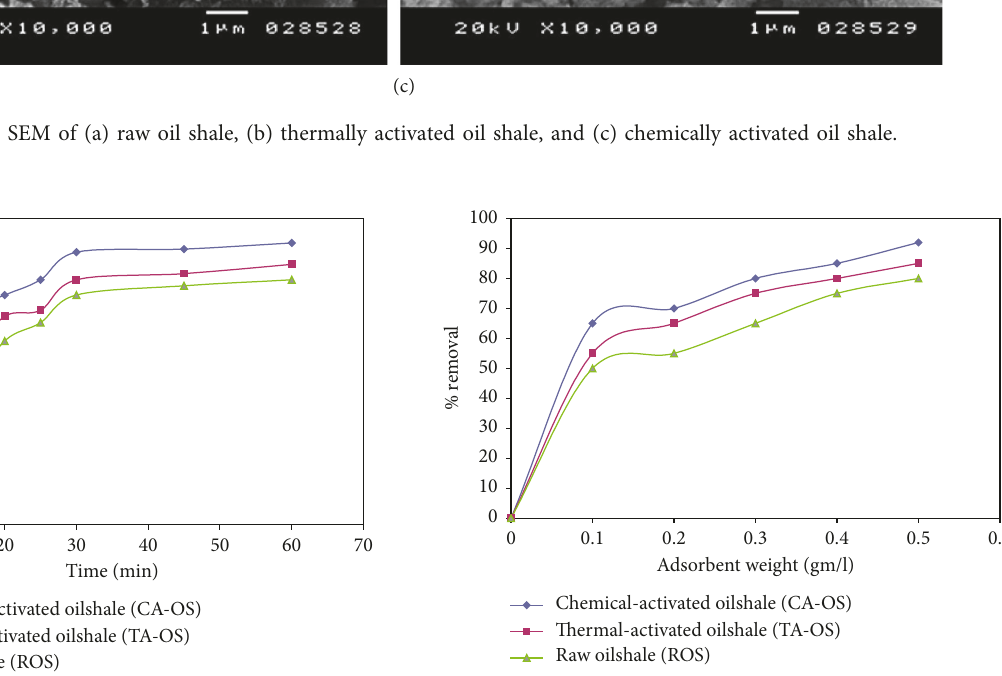
Figure 3: Comparing the effect of contact time on the percentage removal of Zn.